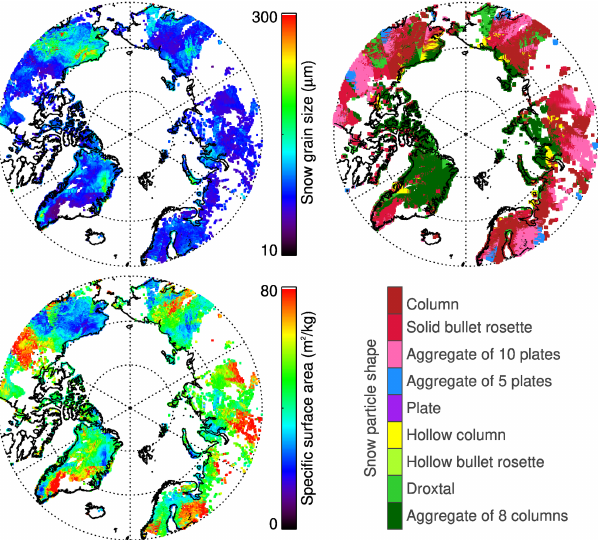
Figure 11. (a) Map of SGS retrieval results from Sentinel measure- ments in the north of Greenland from 26 March 2018. The black- encircled area represents the SMART retrievals of the SGS along the flight track. The dashed red circle marks a region with increased surface roughness. (b) Time series of both retrieval datasets adapted to the aircraft flight path. Periods matching with the circled area in (a) are shaded in light red. Panels (c) and (d) are similar to (a) and (b) but for SSA. Additionally, the flight altitude is given.